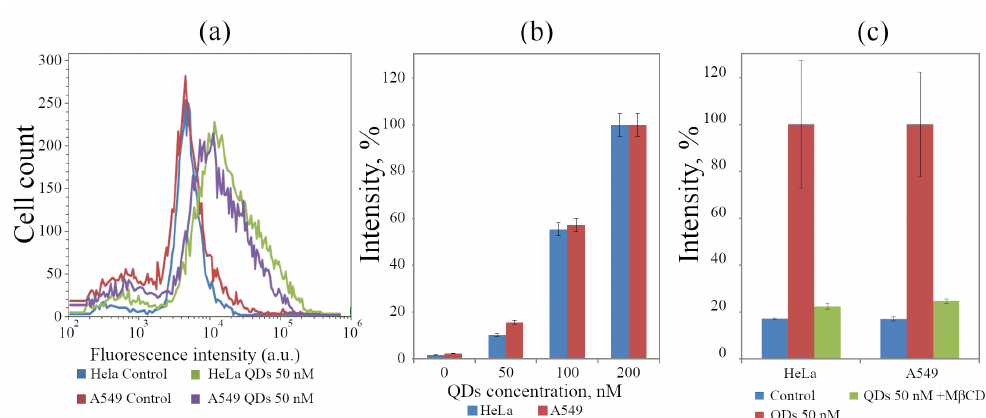
Figure 5. Dynamics of the accumulation of QDs by HeLa and A549 cells obtained by flow cytometry analysis. ( a ) Comparison of the distribution of the luminescence intensity of HeLa and A549 cells in the control and after incubation with 50 nM QDs for 24 h. ( b ) Concentration dependence of QD association with HeLa and A549 cells in the control and after incubation with QDs at different concentrations (50–200 nM) for 24 h. ( c ) FACS analysis of QD accumulation (50 nM, 24 h) by HeLa and A549 cells saturated with Methyl- β -cyclodextrin. The results are presented as a mean ± standard error of at least 40 cells for each case. Three independent experiments were carried out.